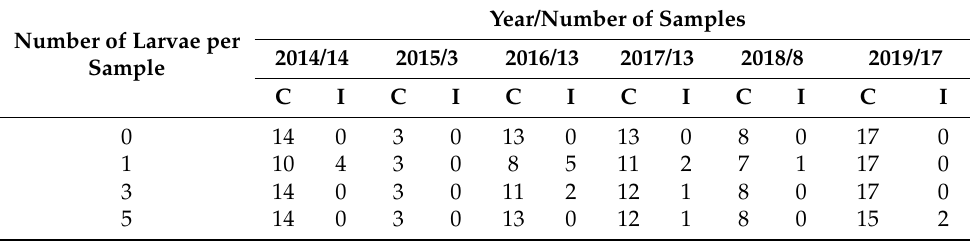
Table 2. Sample qualitative evaluation by the level of contamination in PT from 2014 to 2019. Number of Larvae